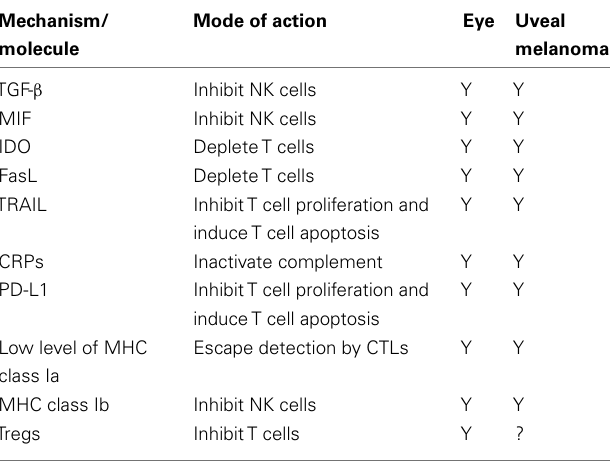
Table 2 | Mechanisms and molecules that maintain immune privilege in the eye and are “plagiarized” by uveal melanoma metastases to escape immune